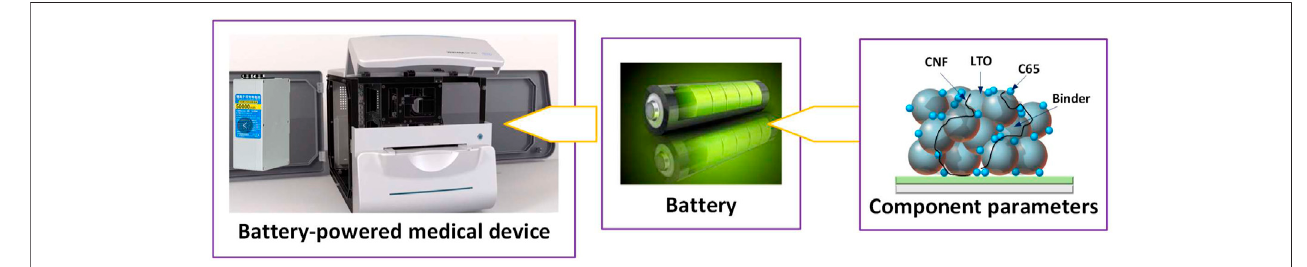
FIGURE 1 | Main component parameters within Li-ion battery for battery-powered medical